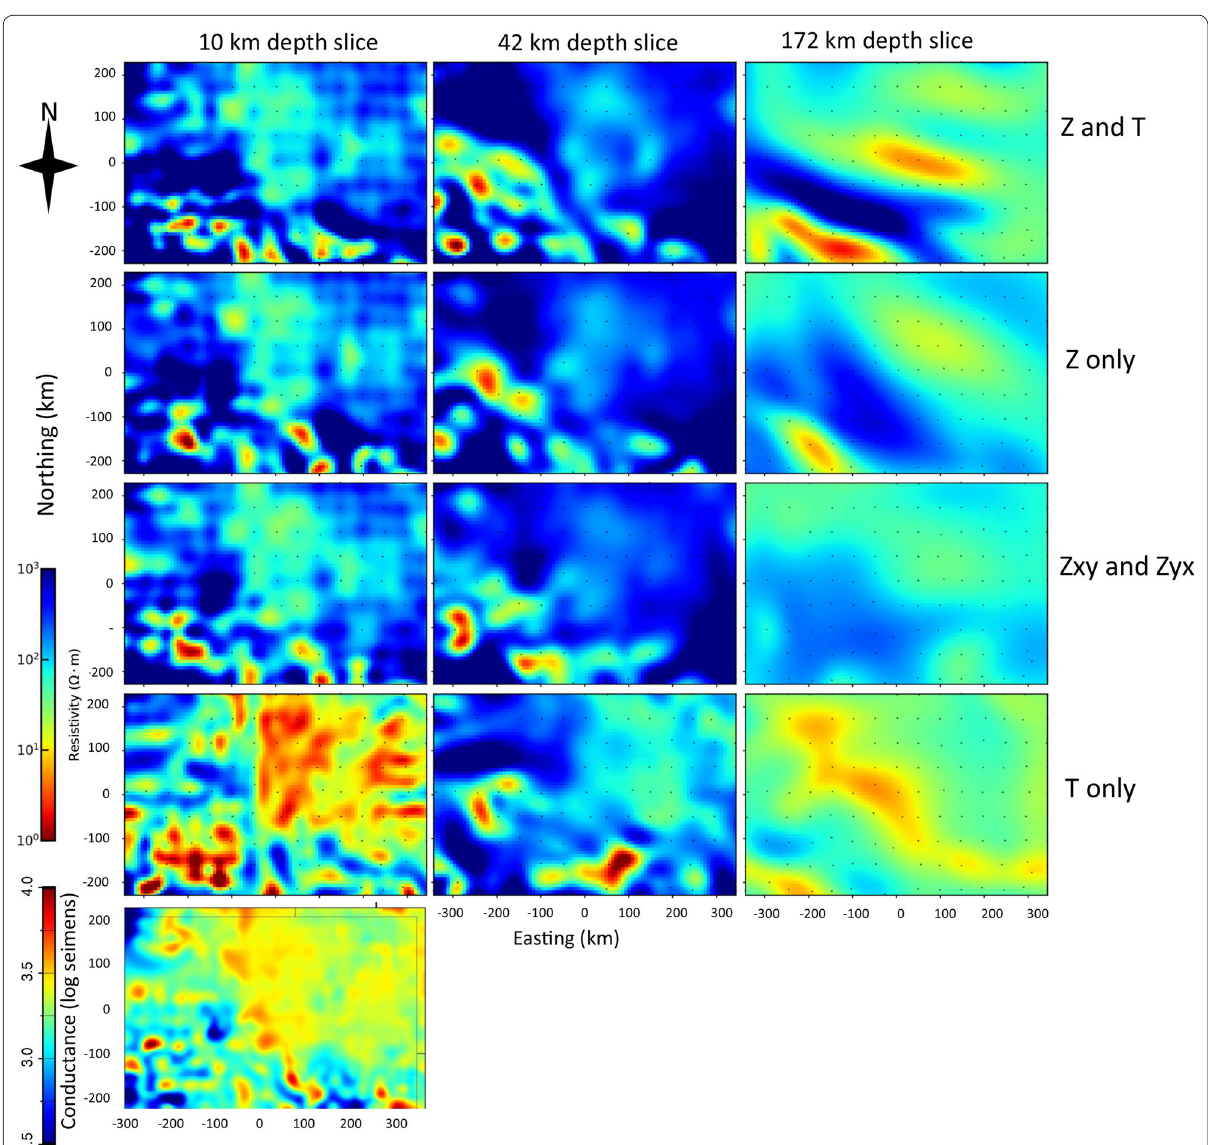
Fig. 16 Depth slices at 10, 31 and 185 km for different components of the impedance tensor inverted. Across each row from top to bottom are: full impedance tensor and tipper ( Zxx , Zxy , Zyy , Zyx ), tipper only ( Tzx , Tzy ), full impedance tensor only ( Zxy , Zyx , Zxx , Zyy ), off-diagonals of impedance tensor ( Zxy , Zyx ), tipper ( Tzx , Tzy ) and conductance of the full impedance and tipper from 0 to 10